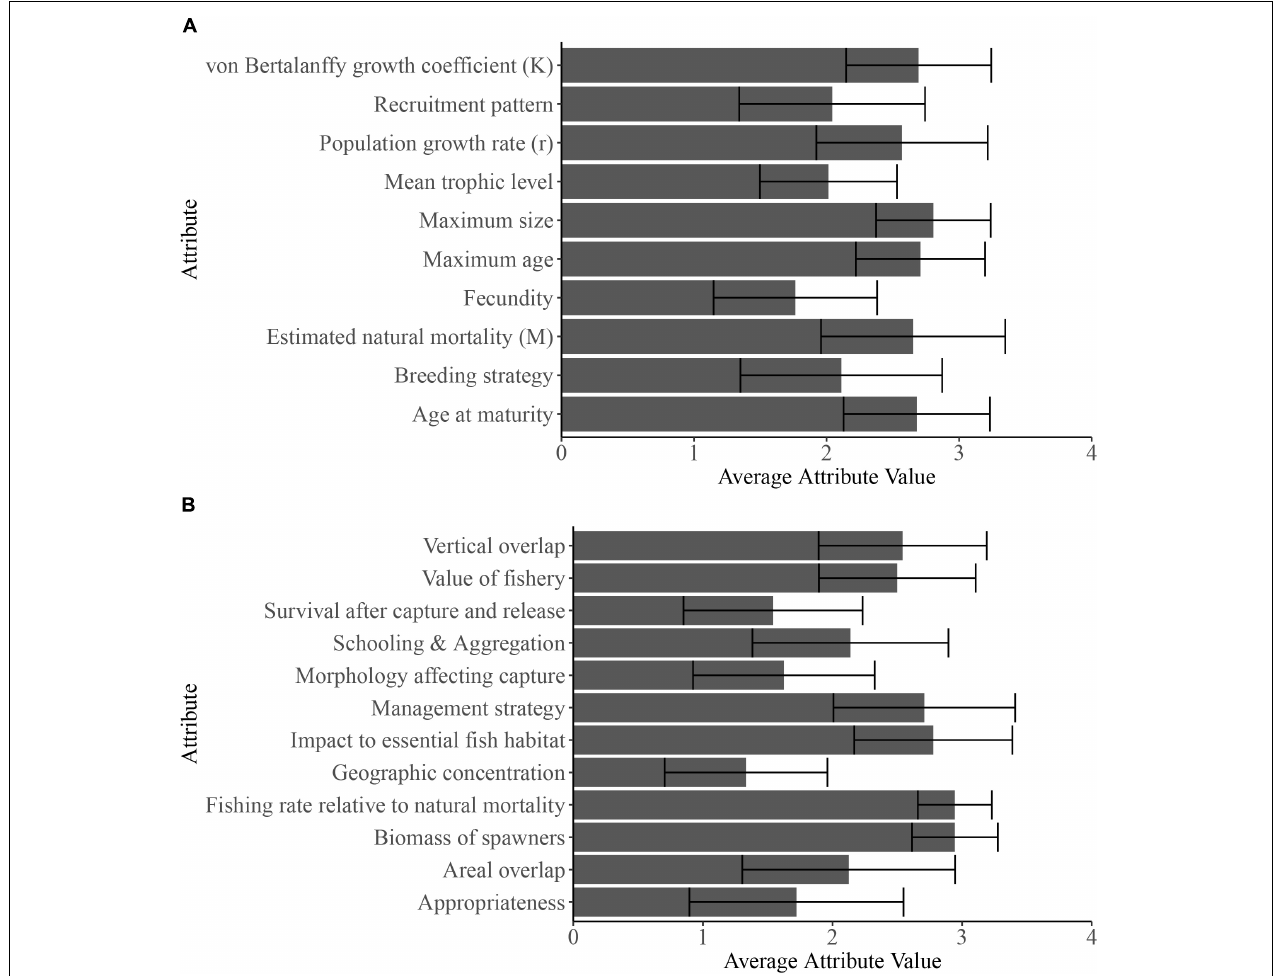
FIGURE 2 | Averages of each attribute score for the (A) 10 productivity (‘P’) and (B) 12 susceptibility (‘S’) attributes for the 72 stocks. Error bars represent + / − 1 standard deviation. Supplementary Table S1 provides details about the attribute categories, and the Supplementary Information provides criteria and for attribute scoring. Supplementary Table S2 provides the attribute scores for each stock and